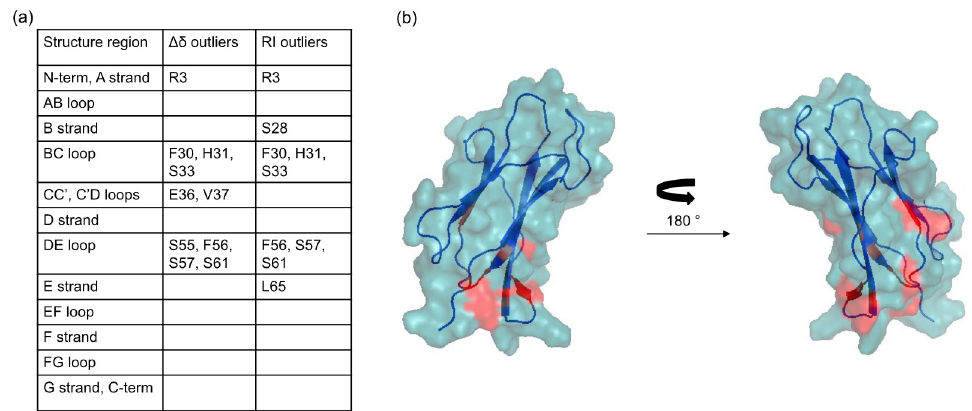
Figure 6. ( a ) Synopsis of β 2m positions that proved most affected, i.e., displaced more than one standard deviation from the average, by the presence of MPA-AuNP and their secondary structure element location; ( b ) β 2m cartoon highlighting in red the locations of the outlier residues.